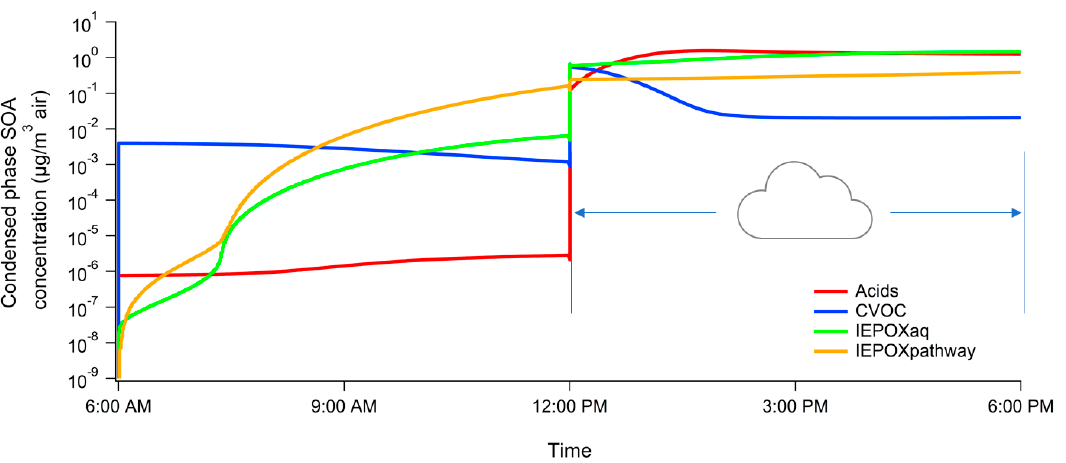
Figure 2. Organic acids, carbonyl-containing VOCs (CVOCs), isoprene epoxydiol (IEPOX), and IEPOX secondary organic aerosols (SOA) mass concentrations in Simulation 1 with aerosol pH 1 and cloud pH 4.